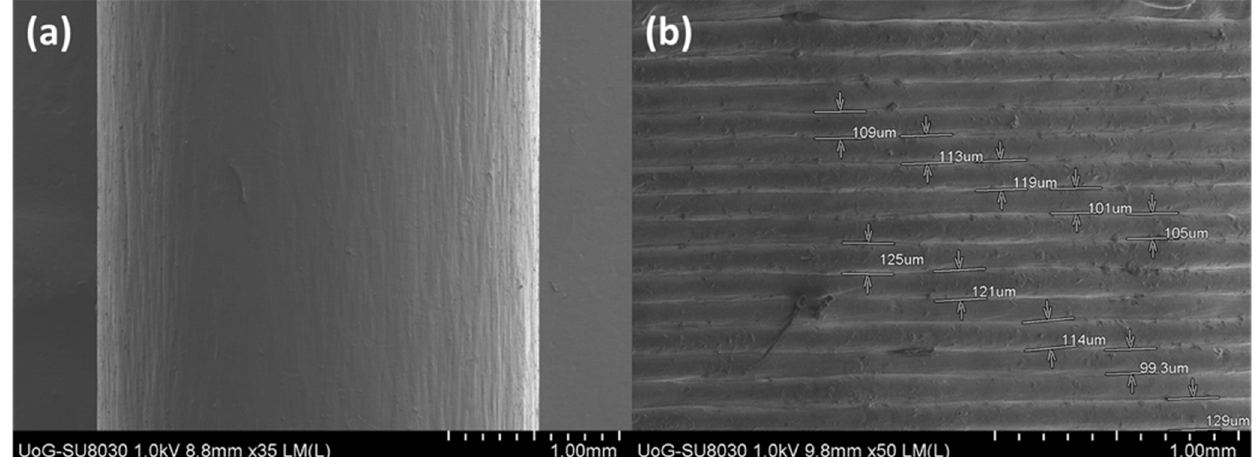
Figure 5. SEM images of ( a ) drug loaded 3D printing filament and ( b ) 3D printed fruit chew.